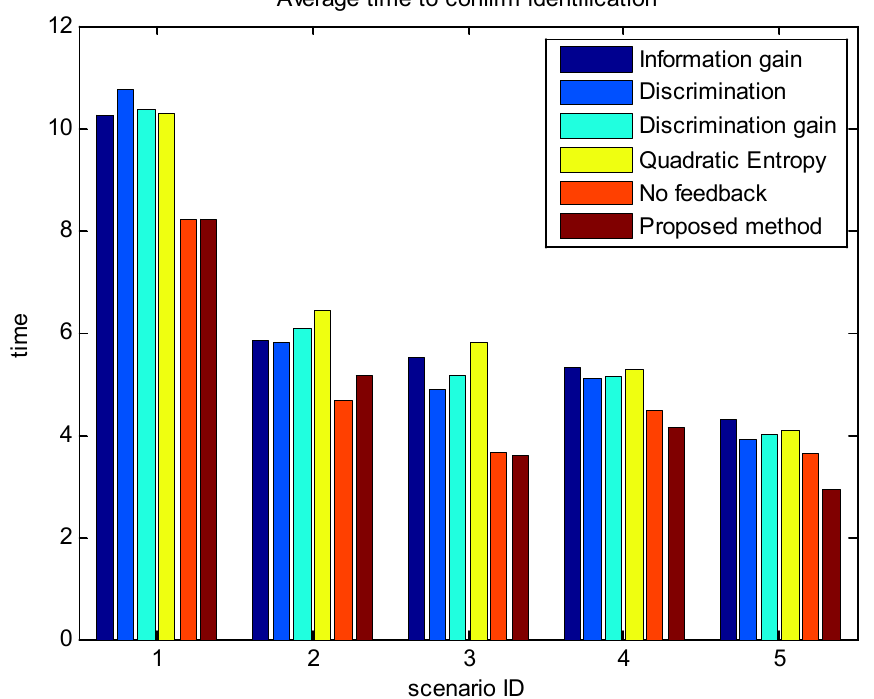
Figure 13. Comparison chart of average confirmation recognition time based on various algorithms under condition 3.